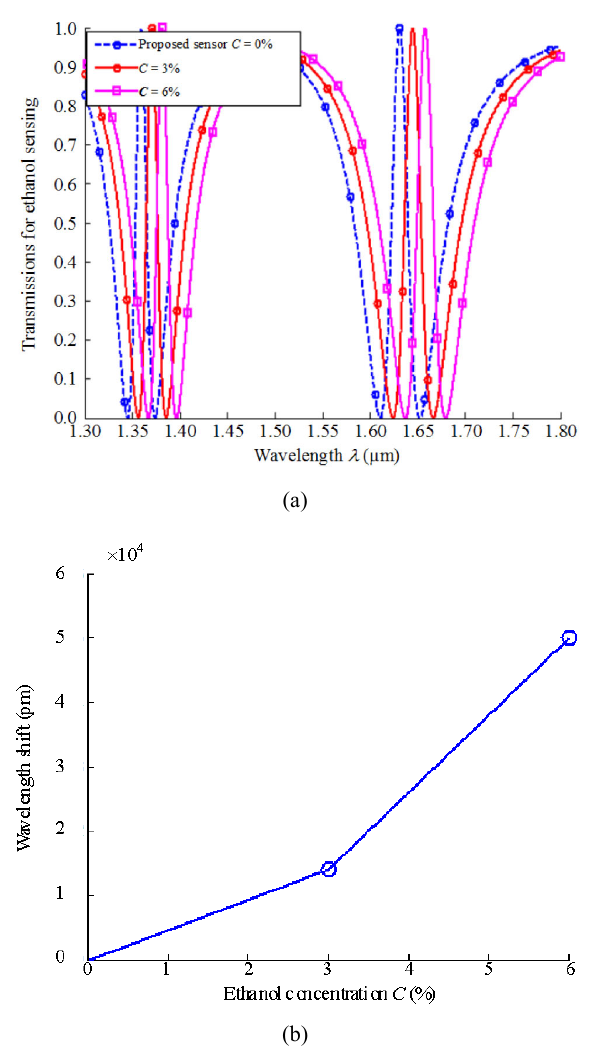
Fig. 7 Characteristics of ethanol sensor: (a) transmissions at the output port 2 for ethanol sensing and (b) resonance wavelength shift at different ethanol